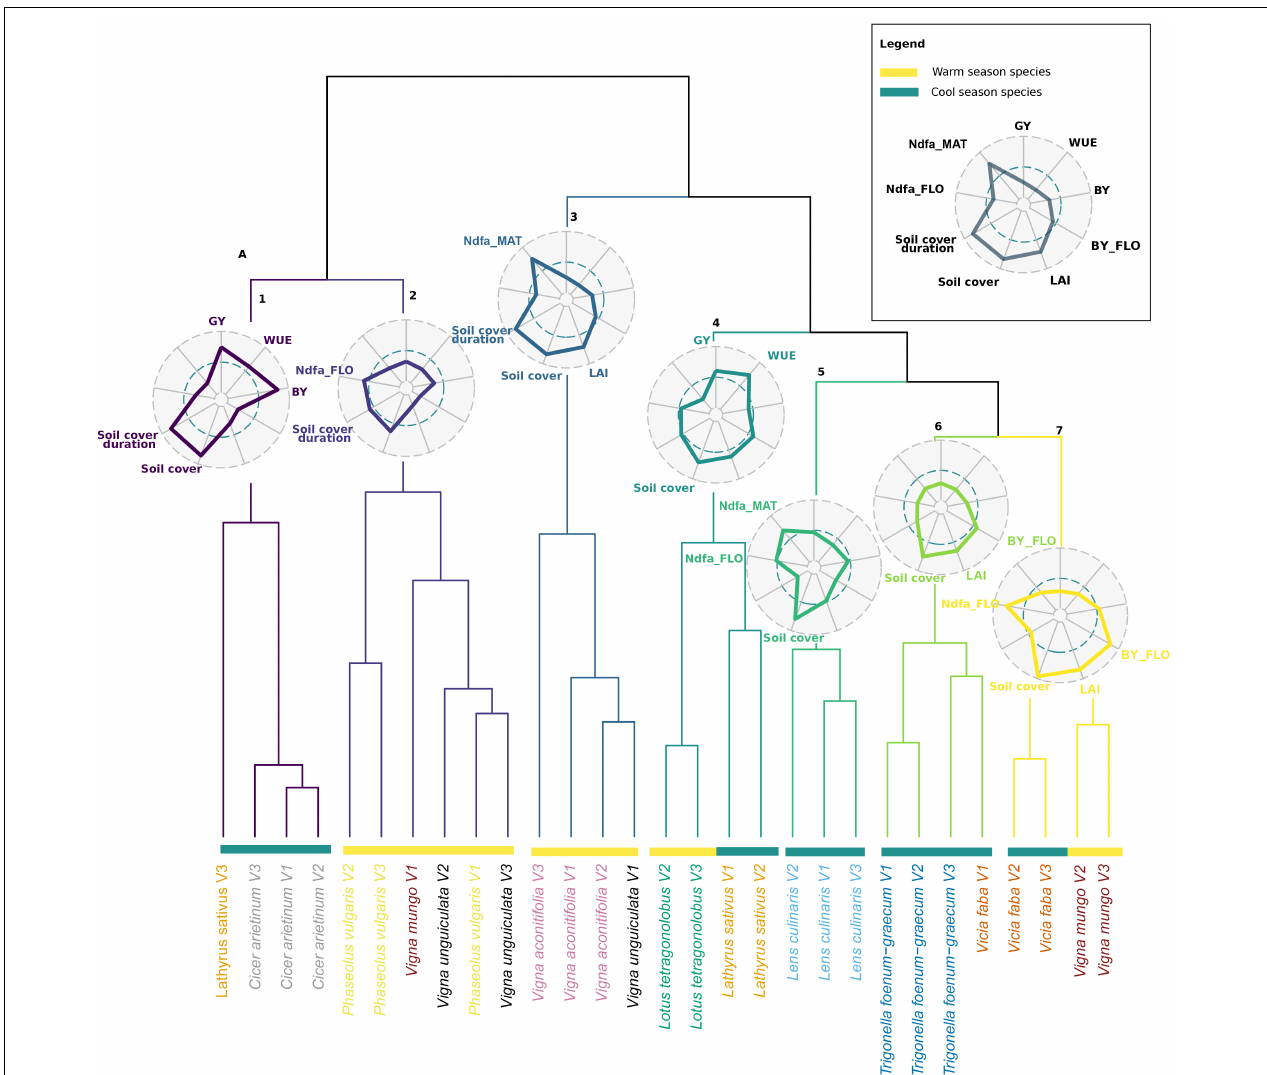
FIGURE 3 | Hierarchical clustering analysis (HCA) of the 30 pulse varieties based on mean value of agroecosystem properties ( n = 3). The names of varieties belonging to the same species are written in the same color. Warm and cool season species are depicted with yellow and green bars, respectively. Radars represent the mean (standardized to maximum) value of agroecosystem properties of each cluster. Colors in radar plots correspond to branch color in the